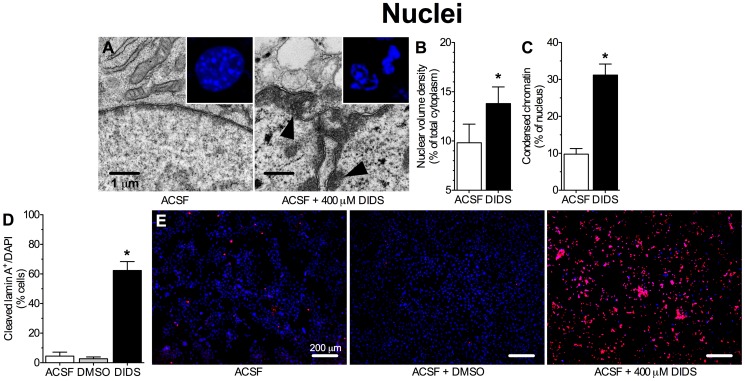
DIDS (400 µM) treated nuclei exhibit apoptotic chromatin condensation, nuclear envelope shrinkage and fragmentation of the nuclear membrane into apoptotic bodies.(A) Sample TEM images of nuclei from neurons treated as indicated for 24 hrs. Arrows indicate condensed chromatin beads. Inset: DAPI-stained chromatin distribution in healthy (ACSF) and apoptotic (DIDS-treated) nuclei. (B) Summary of nuclear volume density from samples in (A). (C) Summary of chromatin volume density from samples in (A). (D) Summary of cleaved lamin A expression normalized to DAPI-stained nuclei following 24 hrs treatment. (E) Sample immunohistochemical (IHC) fluorescent confocal microscopy images of cleaved lamin A (red) and DAPI (blue) staining in neurons from Fig. 5D. Lamin A IHC experiments were repeated 4 times. Data are mean ± SEM. Asterisks (*) indicate significant difference from normoxic controls (p<0.05).